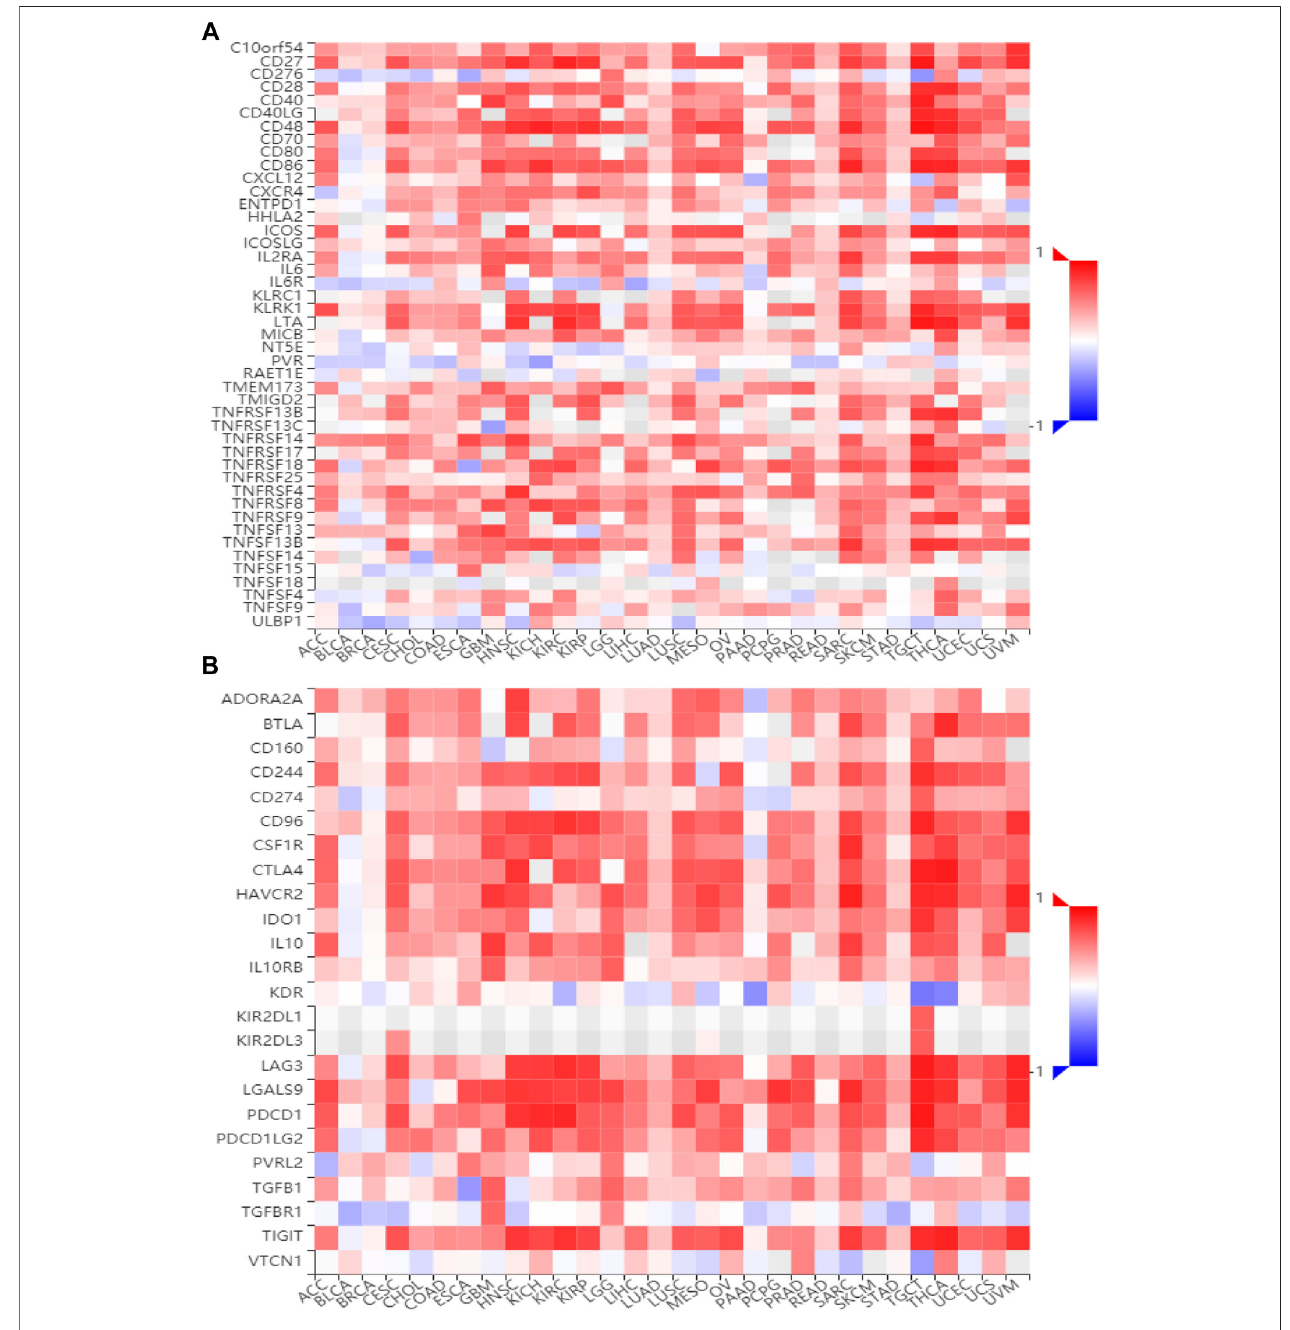
FIGURE 7 | Correlation between BATF and immune regulator expression. (A) The expression correlation between BATF and immune stimulators. (B) The expression correlation between BATF and immune inhibitors.